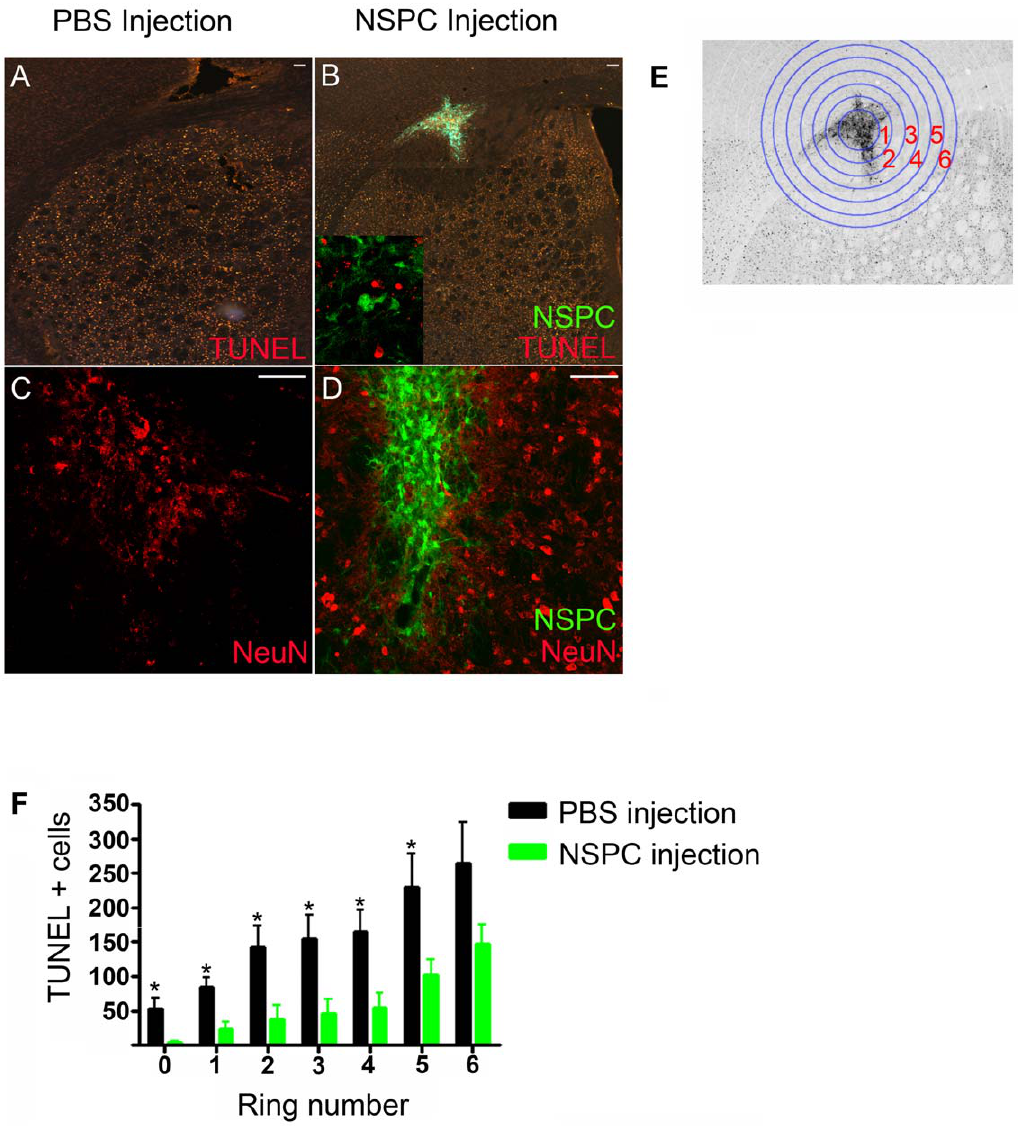
Figure 1. NSPCs protect against 30 minute MCAO. ( A–D ) Coronal histological sections through the ischemic striatum 3 days following MCAO, stained for TUNEL (A,B) or NeuN (C,D). Mice received intrastriatal injections of exogenous PBS (A,C) or EGFP + NSPCs (B,D,E) 72 hr prior to MCAO. Inset in (B) shows 40 6 magnified view of the injection site. ( E ) Monochrome conversion of image shown in B to demonstrate concentric ring structures used for Sholl analysis. ( F ) Quantification of TUNEL + cells using Sholl analysis performed on fluorescent images. *p , 0.05, n=5 mice per group. Scale bar: A,B = 20 m m; C,D = 10 m m. doi:10.1371/journal.pone.0009767.g001 [38]. HIF-1 a wt/wt and HIF-1 a fl/fl NSPC cultures were incubated for 24 hr with adenovirus harboring a bacterial Cre-recombinase gene sequence to confer Cre expression (Ad-CMV-Cre). As shown in Figure 5A, transduction of NSPC cultures with Ad-CMV-Cre resulted in excision of HIF-1 a exon 2 in HIF-1 a fl/fl NSPCs (HIF- 1 a D / D ), but not in HIF-1 a wt/wt NSPCs, as indicated by PCR analysis of genomic DNA isolated 24 hr following removal of Ad- CMV-Cre. HIF-1 a transcriptional activity was completely abol- ished as assessed by the inability of nuclear extract proteins to bind the hypoxia response element (HRE) in HIF-1 a D / D cells, but not in HIF-1 a wt/wt cells (Figure 5B). HIF-1 a gene deletion in NSPCs also resulted in a 50% reduction of VEGF release by HIF-1 a D / D NSPCs compared to HIF-1 a wt/wt NSPCs in response to anoxia (Figure 5C). HIF-1 a gene deletion had no effect on NSPC survival